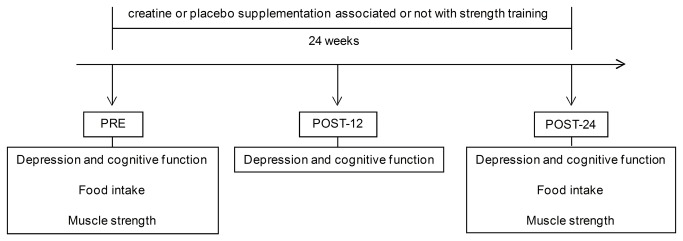
Experimental design.